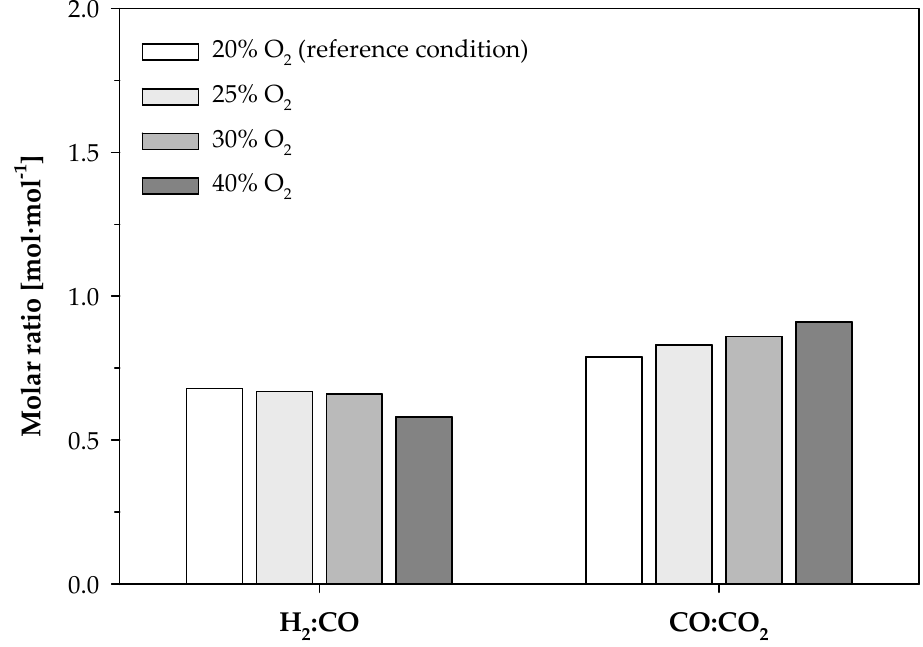
Figure 9. Effect of O 2 concentration ( φ ) in gasification agent on the H 2 :CO and CO:CO 2 molar ratios during air gasification of RFB from eucalyptus (SBR = 0.0 kg steam ∙ kg − 1biomass —Tables 3 and 4).